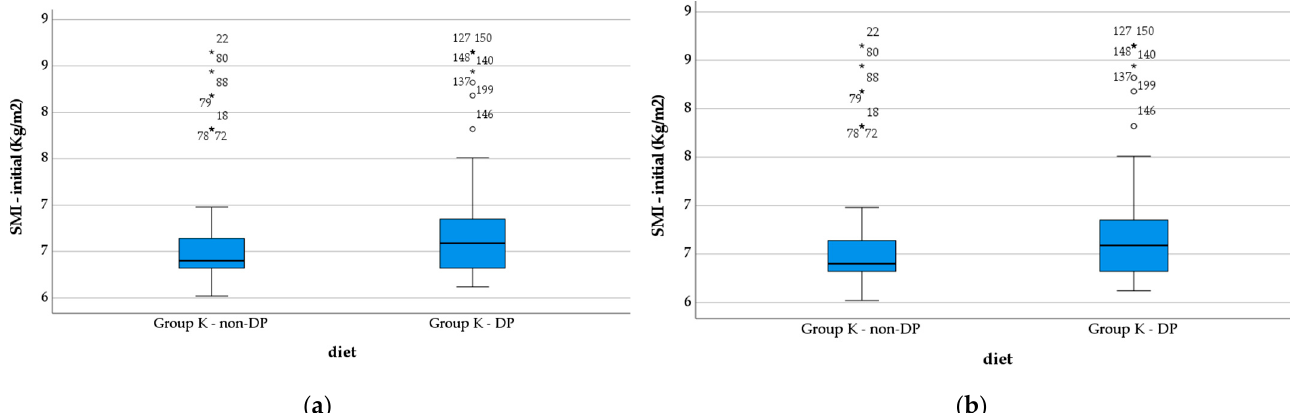
Figure 4. Evolution of the SMI in study groups: ( a ) initial vales; ( b ) final values. Group K—non-DP: Group K without diet therapy and probiotics; Group K—DP: Group K with diet therapy and probiotics. *, extreme outliers; o, mild outliers.